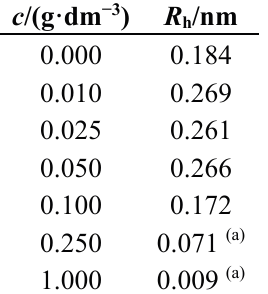
Table 6. Hydrodynamic radius, R h , of the unity NaHy at solutions of the different concentrations, c , and different viscosities, η , at T = 25 °C and at atmospheric